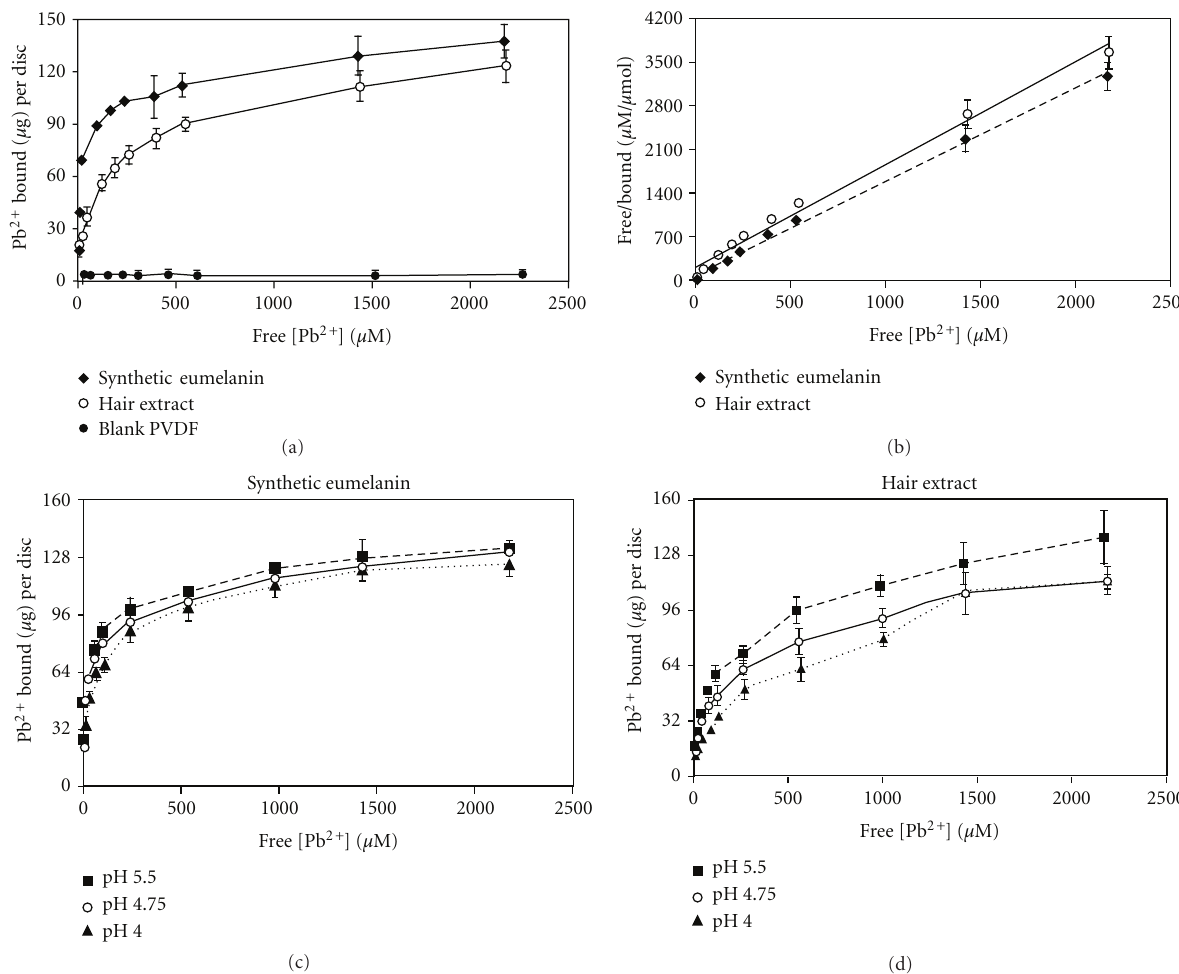
Figure 2: (a) Binding isotherms of Pb 2+ ions to synthetic-eumelanin-coated discs, hair-extract-coated discs, and blank PVDF discs; pH uncorrected titrations of Pb(NO 3 ) 2 in H 2 O. (b) Linearized Langmuir isotherm representation of the data for synthetic-eumelanin- and hair- extracted-coated discs in (a), R 2 ≥ 0 . 98. (c) Binding isotherms to Pb 2+ ions to synthetic-eumelanin-coated discs; titrations of Pb(NO 3 ) 2 in 50mM NaNO 3 (aq.) at initial pH 5.50, 4.75, and 4.00. (d) Binding isotherms to Pb 2+ ions to hair-extract-coated discs; titrations of Pb(NO 3 ) 2 in 50 mM NaNO 3 (aq.) at initial pH 5.50, 4.75, and 4.00. (a–d) Data are average values from at least three independent titrations, each with di ff erent discs; error bars represent one standard